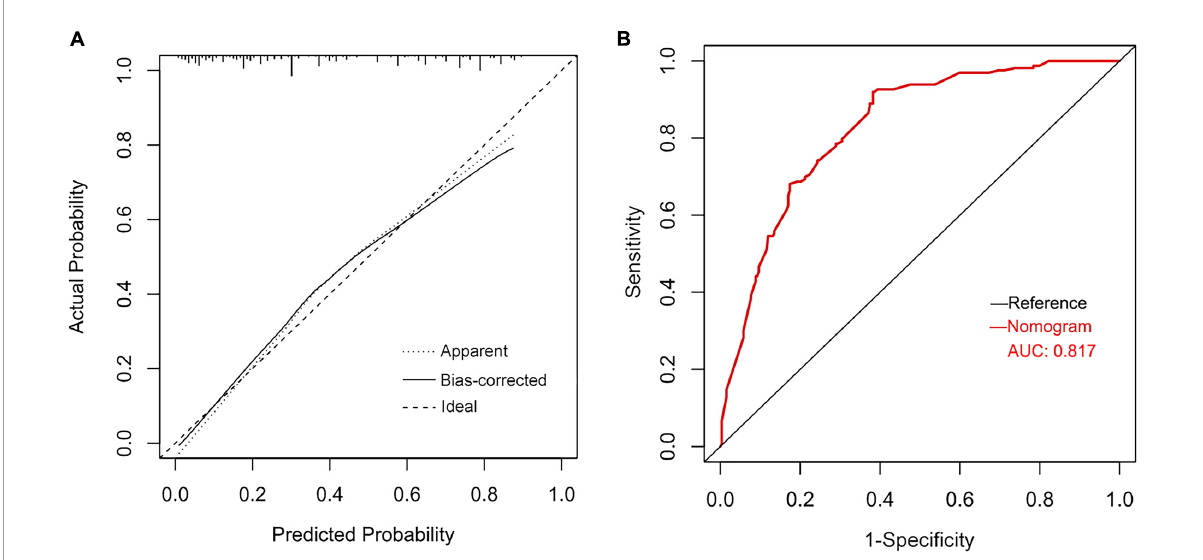
FIGURE2 Calibration plots of the nomogram for predicting POAF after isolated valve surgery (A) and the ROC curve for the nomogram (B)